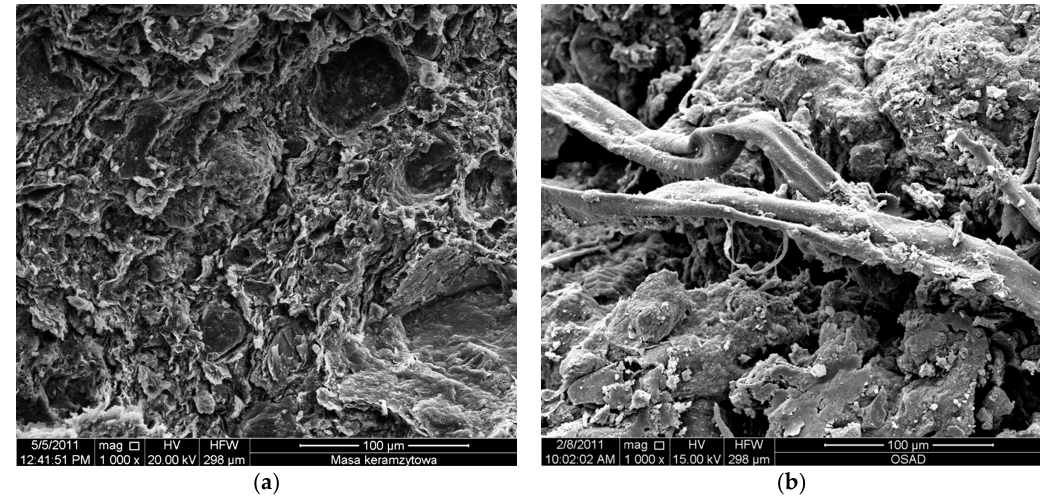
Figure 2. SEM micrographs of: ( a ) clay; and ( b ) sewage sludge. Table 2. Physical-chemical characteristics of sewage sludge from the Sewage Treatment Plant “Hajdów”, Lublin.